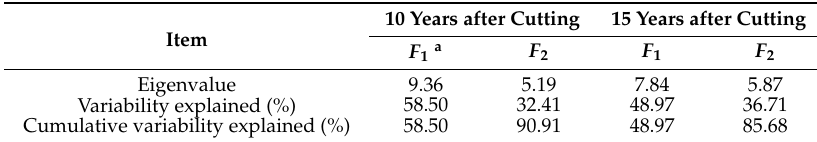
Table 9. Eigenvalue and variability explained by principal